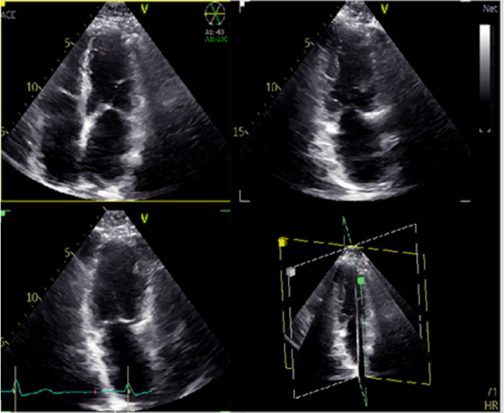
Figure 2. 2D Transthoracic apical view of the left ventricle simultaneously (Tri-plan) from 3 different angles (4CH, 2CH, 3CH view).